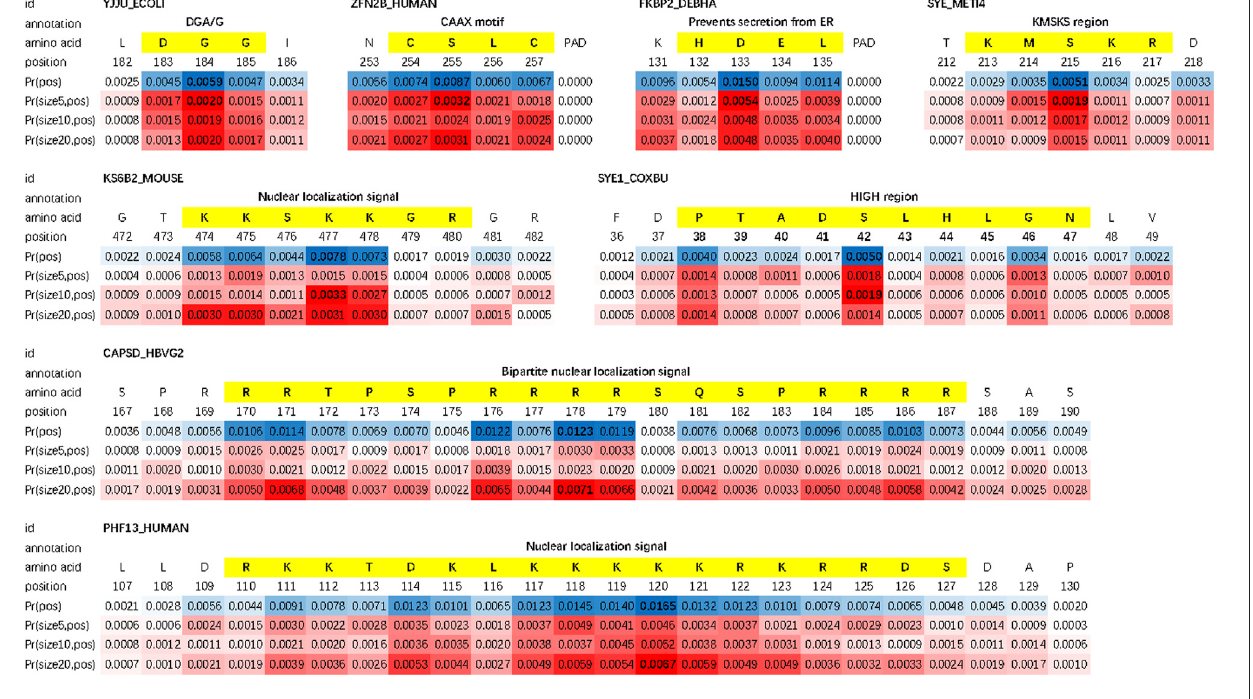
FIGURE 2 | : Examples of matched motifs in different sizes. Their spatial sizes vary from 3 to over 15. Pr ( pos ) is the marginal weight vector on the positional scale and Pr ( sizeK , pos ) is the weight vector of K -sized sub-sequences on the positional scale (similarly hereinafter).